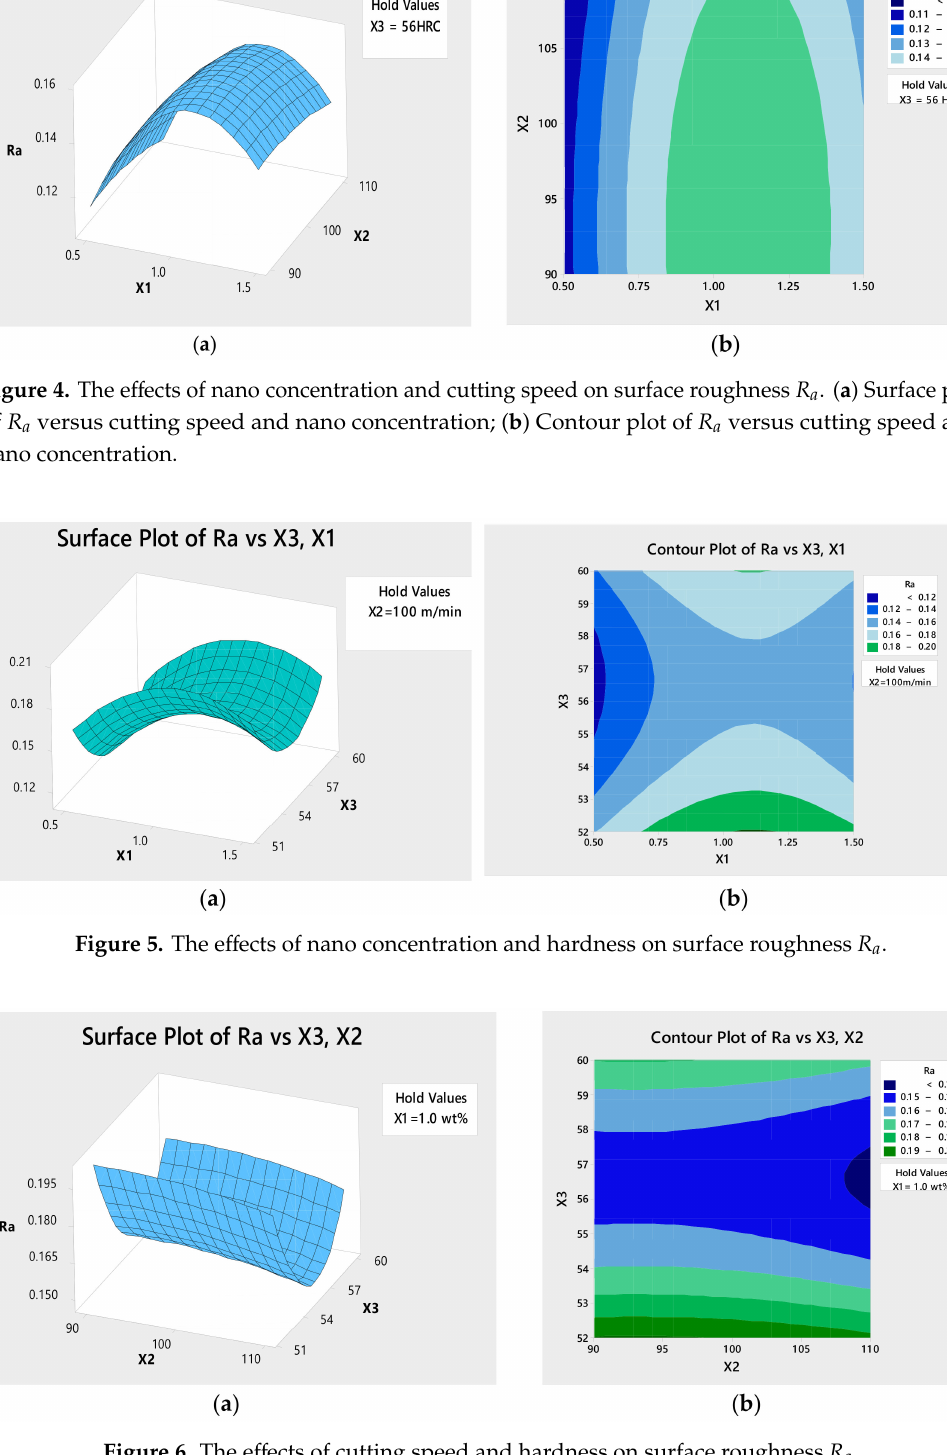
Figure 6. The e ff ects of cutting speed and hardness on surface roughness R a